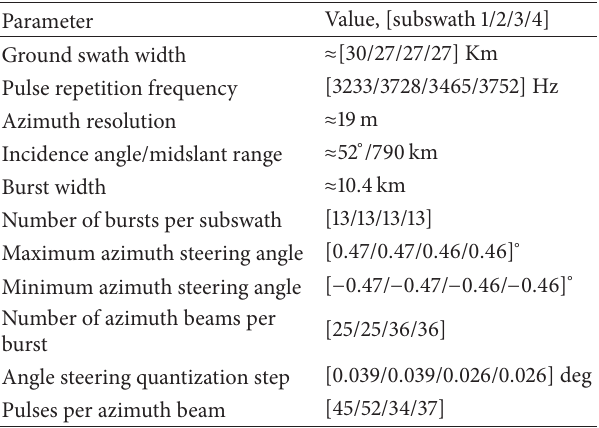
Table 1: Parameters of TSX TOPS data take over DLR